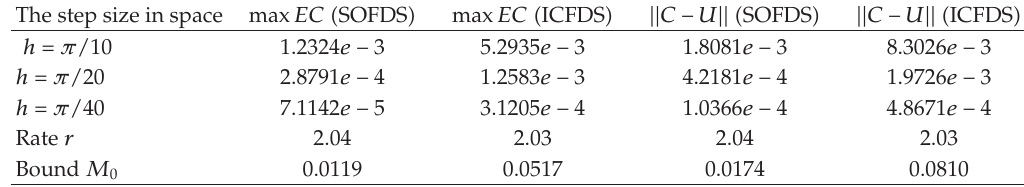
Table 2: The comparison of SOFDS and ICFDS in di ff erent